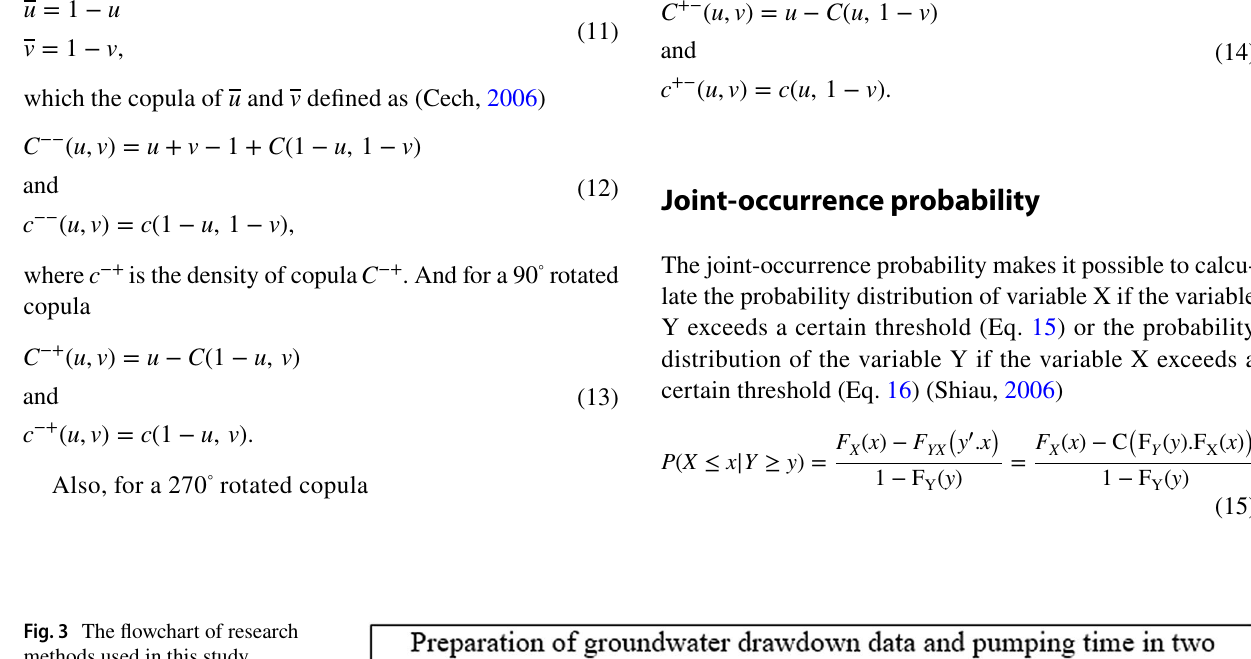
Fig. 3 The flowchart of research methods used in this